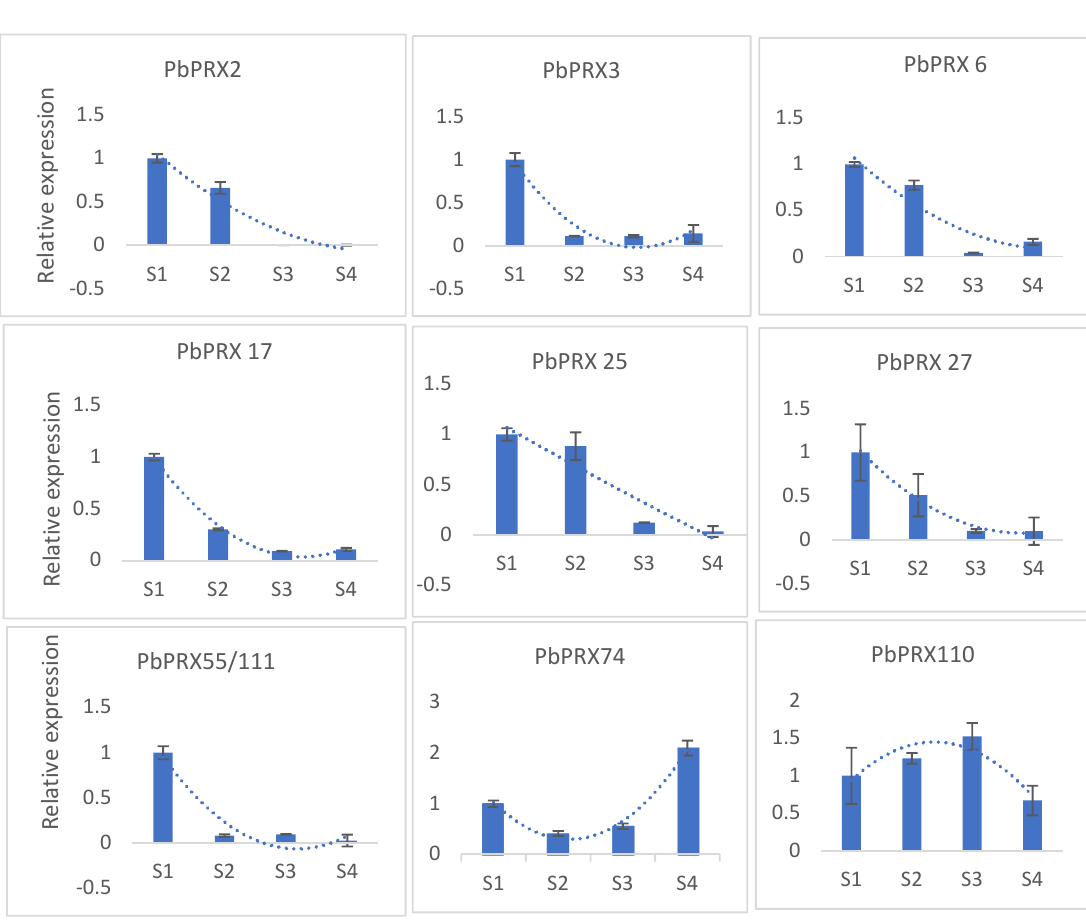
Figure 7. Expression levels of some particular PbPRX gene of “Dangshansu” pear fruit S1:15 days after full bloom (DAFB); S2:36DAFB; S3:79DAFB; S4:107DAFB.